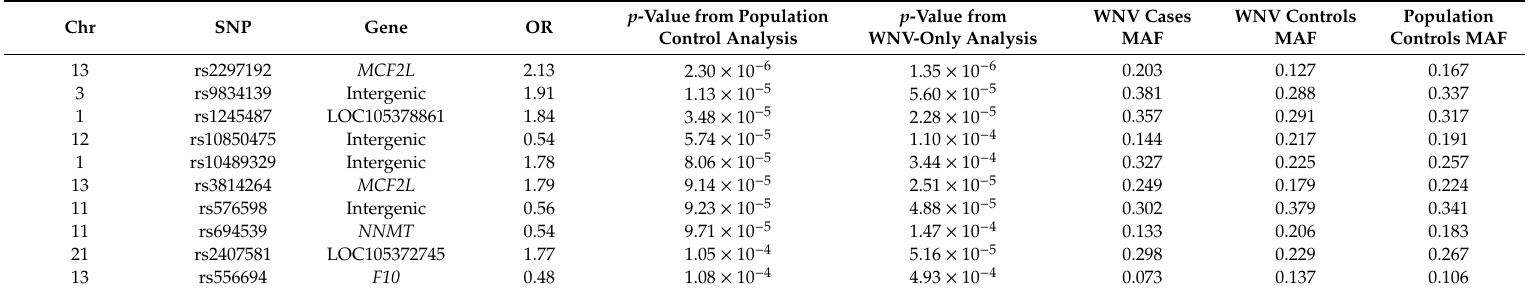
Table 2. Top SNPs following individual variant analysis of the imputed datasets of WNV severe cases, non-severe WNV-infected controls, and population controls from the Wisconsin Longitudinal Study on Aging. The table shows the top 10 results by chromosome (Chr), single-nucleotide polymorphism (SNP), odds ratio (OR), p -value from the combined WNV cohort and population control analysis, p -value from the WNV-only cohort analysis, and minor allele frequency (MAF) within the WNV severe cases, WNV-infected non-severe controls, and population controls from the Wisconsin Longitudinal Study on Aging. None of the interactions passed the Bonferroni-corrected p -value of 5 × 10 − 8 . Gene acronyms: MCF.2 Cell Line Derived Transforming Sequence Like ( MCF2L ), Nicotinamide N -Methyltransferase ( NNMT ), Coagulation Factor X ( F10